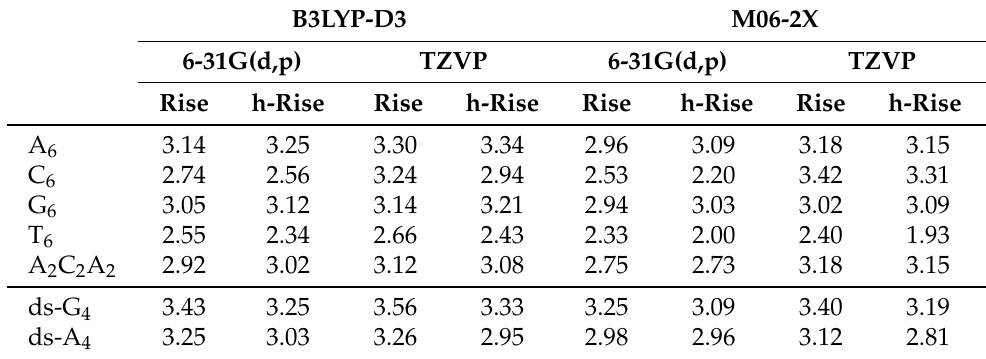
Table 1. Predicted average rise and helical rise (Å) for the systems studied at the DFT